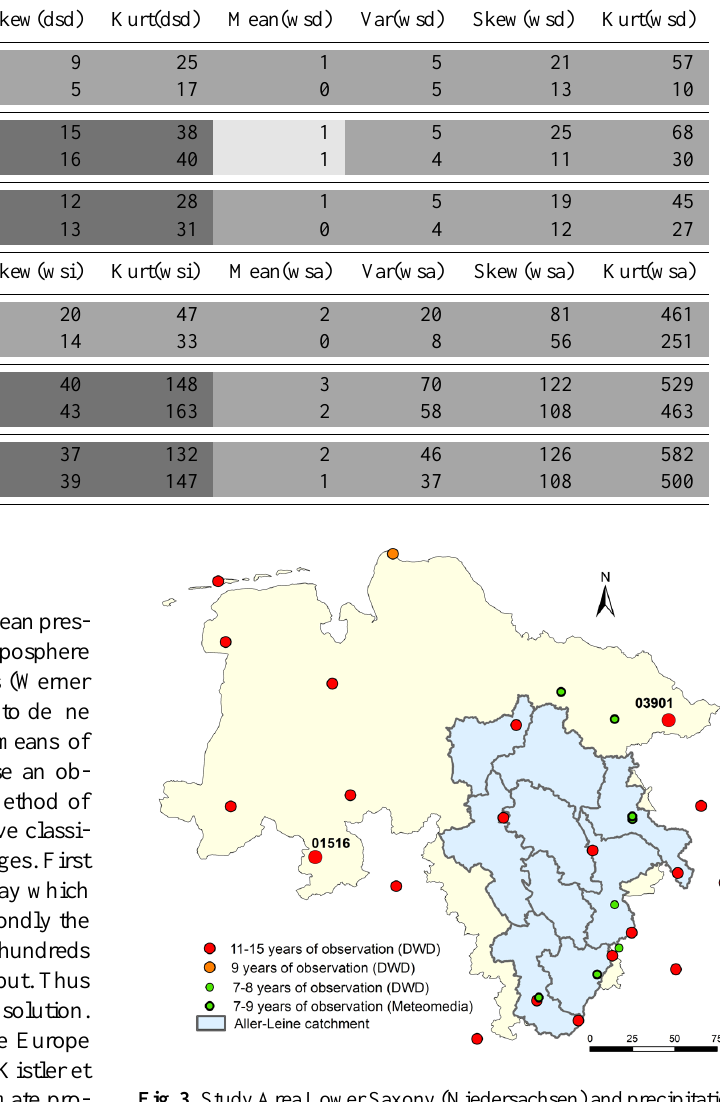
Fig. 3. Study Area Lower Saxony (Niedersachsen) and precipitation network with two stations indicated for extreme value comparison (see. Fig. 5); the station shown in Fig. 5 marked with slightly bigger points than the other